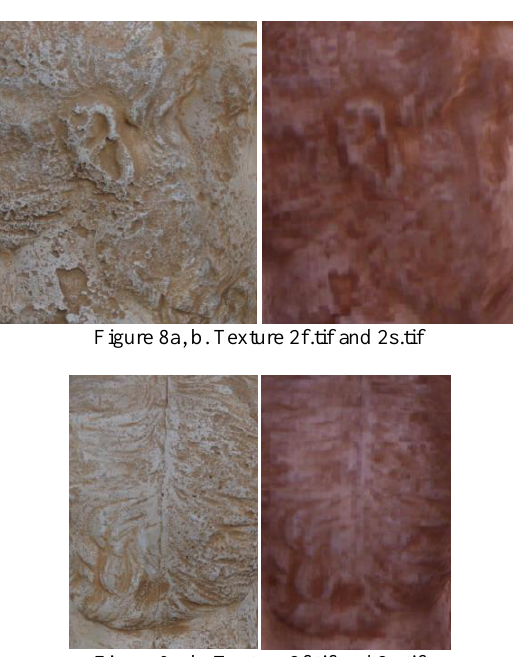
Figure 9a, b. Texture 3f.tif and 3s.tif